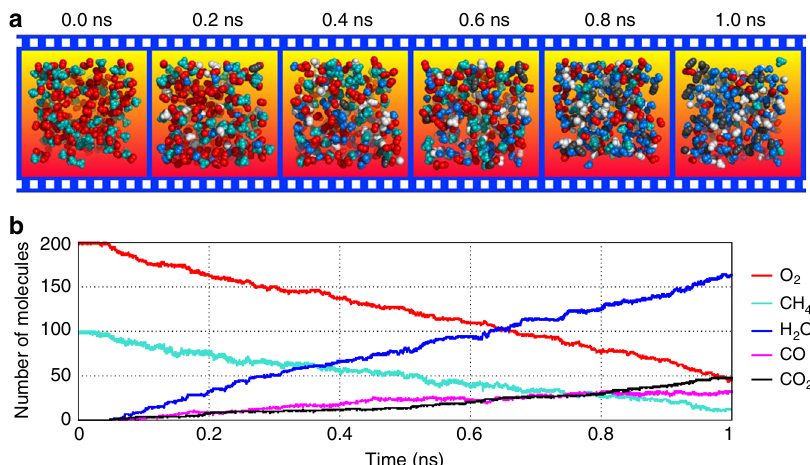
Fig. 1 Real-time dynamics of methane combustion. a Snapshots of the partial combustion system extracted from the reactive MD simulation of methane combustion (the time interval is 0.2 ns). The main molecular species of CH 4 , O 2 , H 2 O and CO 2 molecules are colored in cyan, red, blue and black, respectively. Other molecular species are colored in white. One can see that the number of reaction products were continuously increasing while reactants were being consumed. b Time dependences of the numbers of main molecular species in real-time MD simulation. These curves are smoothed to make them look better and